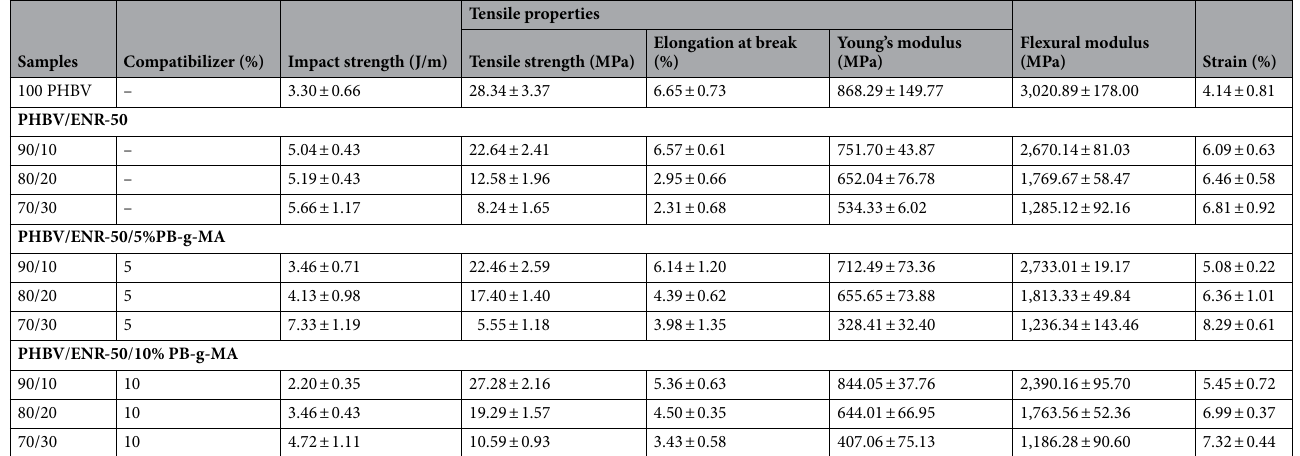
Table 3. Mechanical properties of the PHBV and PHBV/ENR-50 blends.